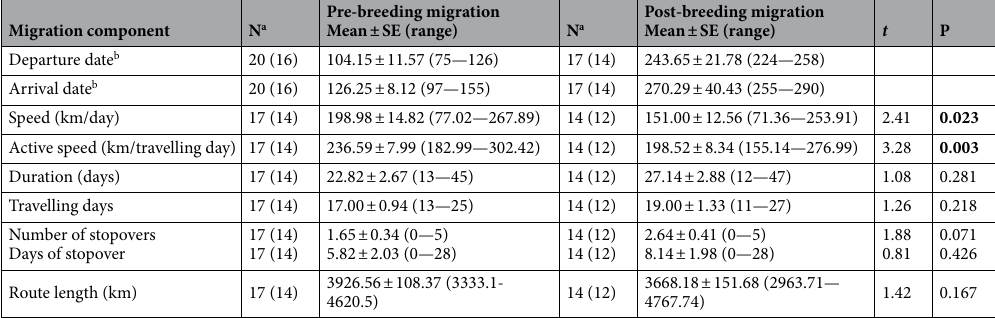
Table 1. Estimates of pre-breeding and post-breeding migration by Black-eared kites GPS-tagged in Delhi during 2014–2018. a Number of migration episodes (number of tagged individuals). b Julian date (1 = 1 January). Differences in mean values were tested by means of a t-test and significant results are highlighted in